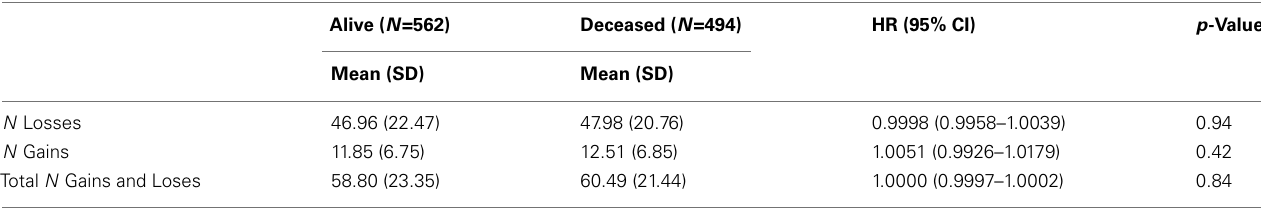
Table 3 | Mean genome-wide CNV burden by vital status and association with overall